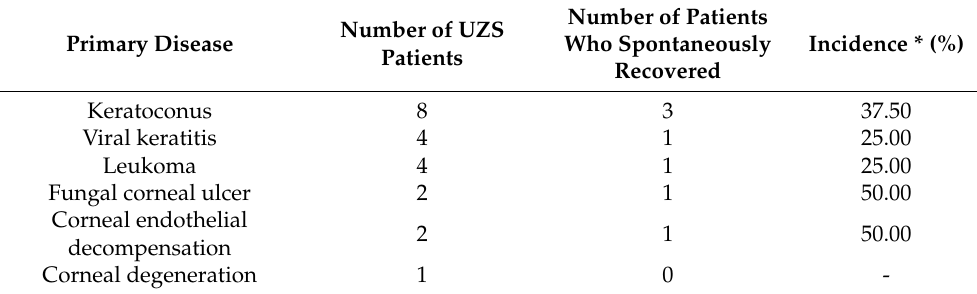
Table 4. Spontaneous recovery from pupil abnormalities in patients who developed UZS after PKP.